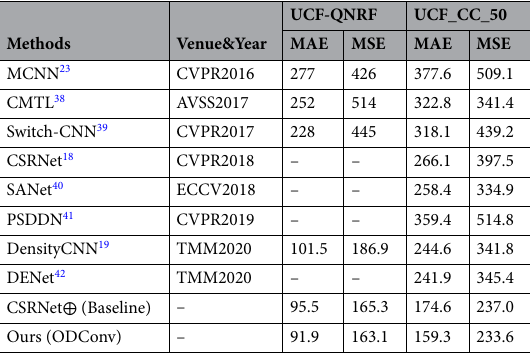
Table 1. Comparisons on UCF-QNRF and UCF_CC_50.